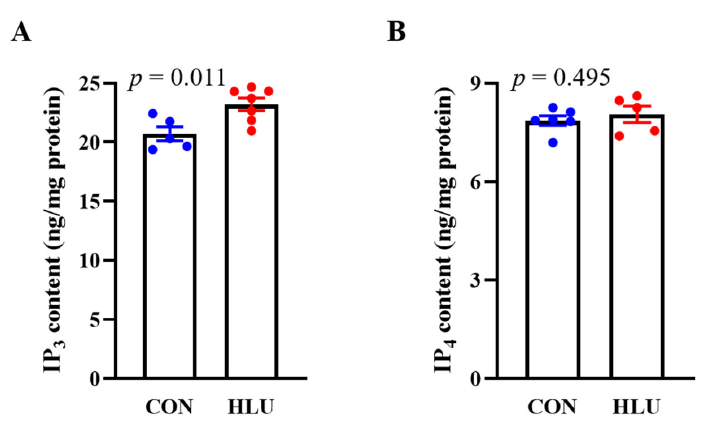
Figure 5. Inositol 1,4,5-tetrakisphosphate (IP 3 ) and Inositol 1,3,4,5-tetrakisphosphate (IP 4 ) content in muscle. ( A ) Content of IP 3 . ( B ) Content of IP 4 . Each circle represented a value. n = 5–7. Data were analyzed by t -test. Data are shown as Mean ± SEM and considered statistically significant at p < 0.05.